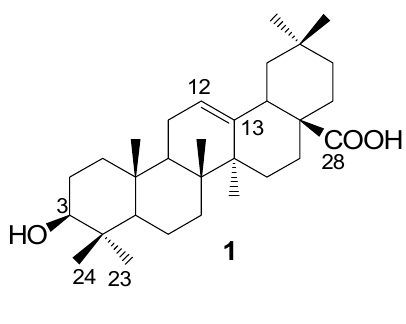
Figure 1 . Structure of oleanolic acid